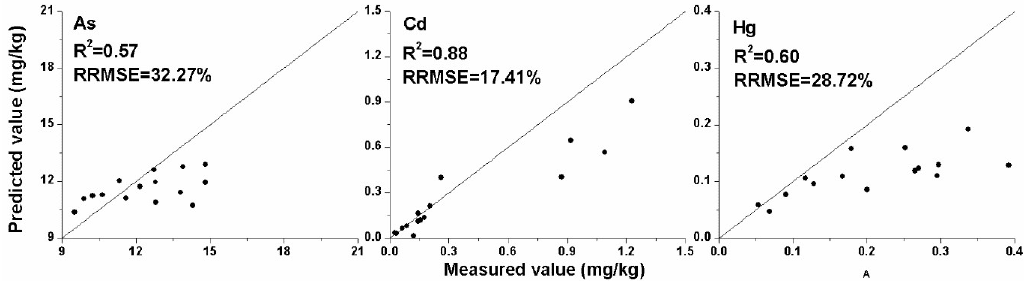
Figure 8. Comparison of observed and predicted contents of As, Cd, and Hg based on the 15 validation soil samples.